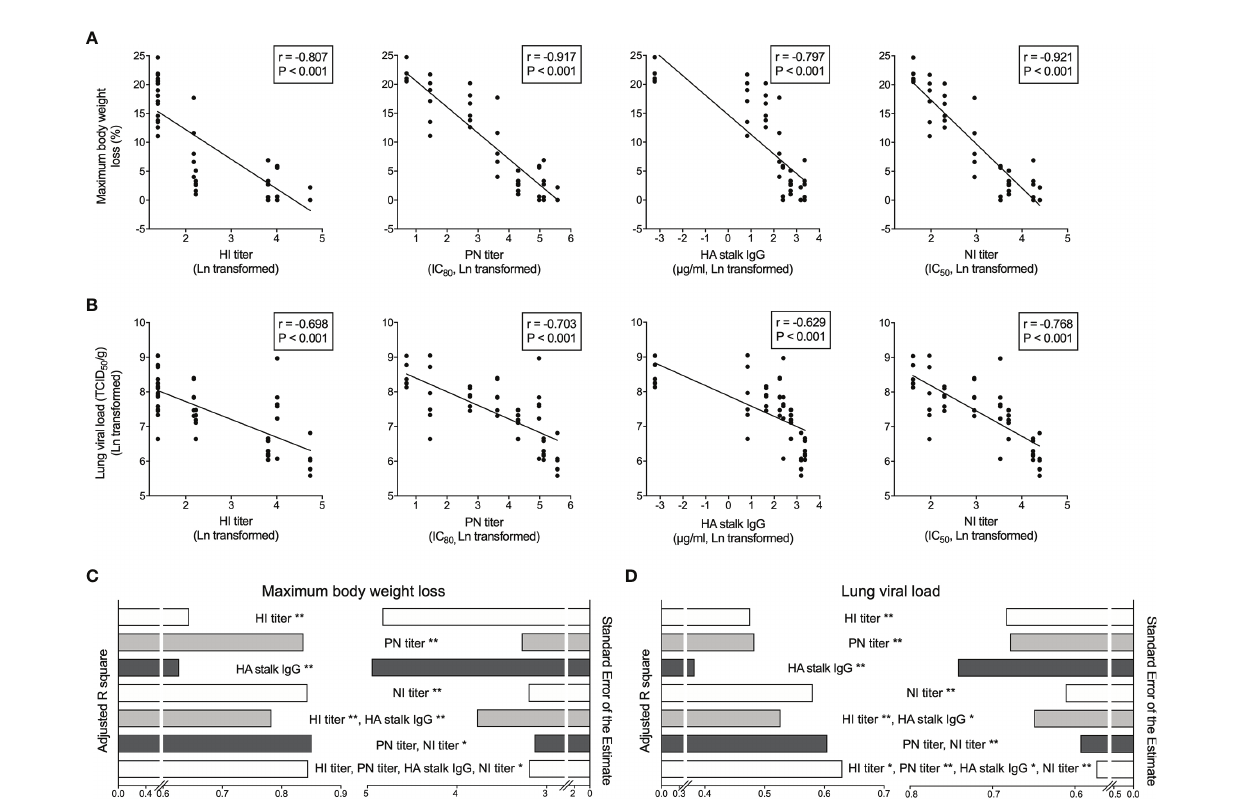
FIGURE 5 | Vaccine elicited HA and NA speci fi c antibodies predict in vivo protection after challenge. (A, B) Hemagglutination inhibition antibodies (HI titer, far left), HA speci fi c neutralizing antibodies (PN titer, central left), total HA stalk speci fi c antibodies (HA stalk IgG, central right), and neuraminidase enzymatic activity inhibiting antibodies (NI titer, far right) signi fi cantly and inversely correlate with the maximum body weight loss (A) and lung viral load (B) in mice after NIBRG-14 virus challenge. Each symbol represents one mouse (A, B) . The linear fi tting curve is plotted as line. Pearson r and P values are noted in each correlation. (C, D) Antibody parameters including HI titer, PN titer, HA stalk IgG and NI titer results were used to predict mice maximum body weight loss (C) and lung viral load (D) in uni- and multiple linear regression models. Adjusted R square (left half) and Standard Error of the Estimate (right half) are shown to indicate the goodness of different models explaining dependent variables. In each model, predictors contributing signi fi cantly are noted. *P < 0.05, **P < 0.01. For detailed model summary and coef fi cients, see Supplementary Tables 2 – 3 . Antibody parameters from each individual subject in clinical trial were put together in silico the same way as sera were combined to make group-and-time-point-wise pooled human sera for mice passive transfer. Geometric mean of antibody parameter was calculated, Ln transformed and centered before being used as independent variables. Maximum body weight loss and Ln-transformed lung viral load were used as dependent variables in regression analyses in SPSS